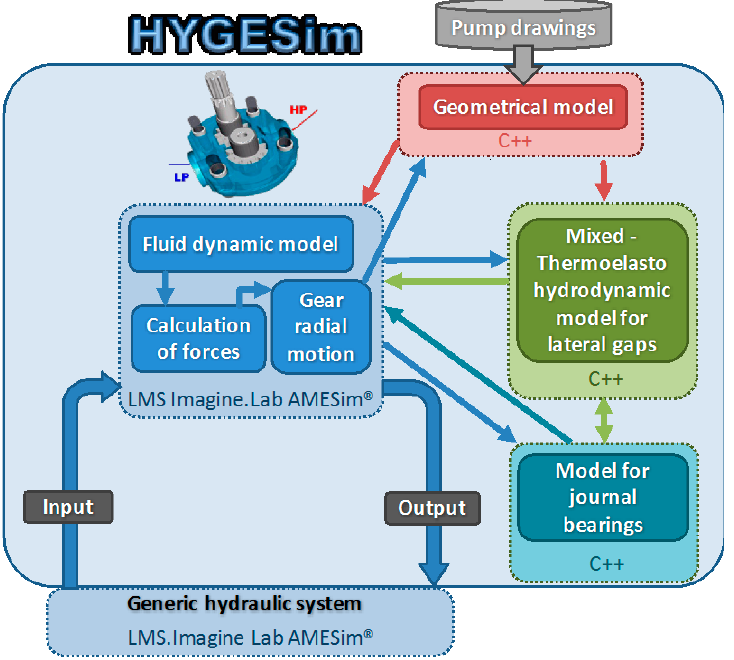
Figure 2. Overview of the structure of HYGESim simulation tool.